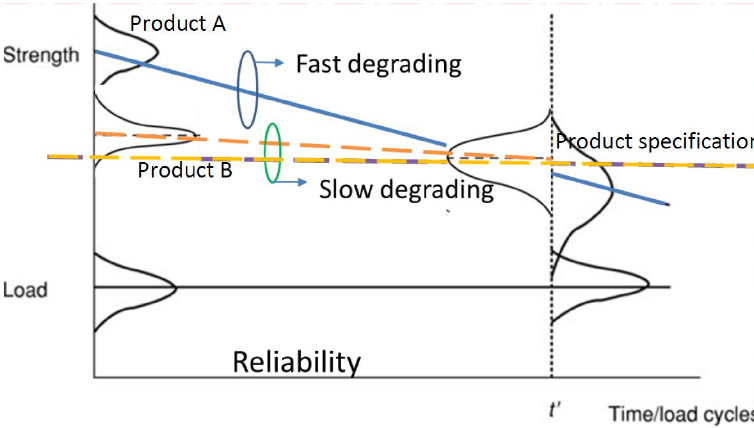
Figure 1. Different between Reliability and Current Quality Practice.